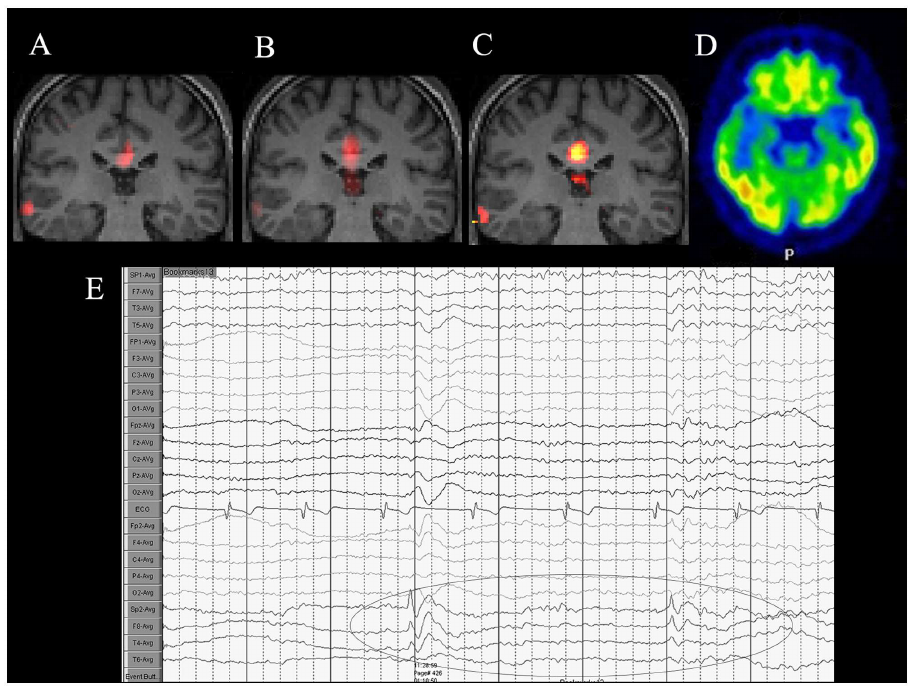
Fig 2. A 38-year-oldman diagnosed with right lateral temporal lobe epilepsy. (A) CoronalfALFF, (B) ALFF, and (C) ReHo revealabnormalactivationin the right lateral temporallobe. An area of activationcould also be found in the corpus callosum, which is considered a part of the default mode network. (D) The corresponding 18 F-FDG PET/CT image reveals low FDG uptake in the right lateral temporallobe region. (E) VEEG depictionof interictal epileptiformdischarges of right temporal